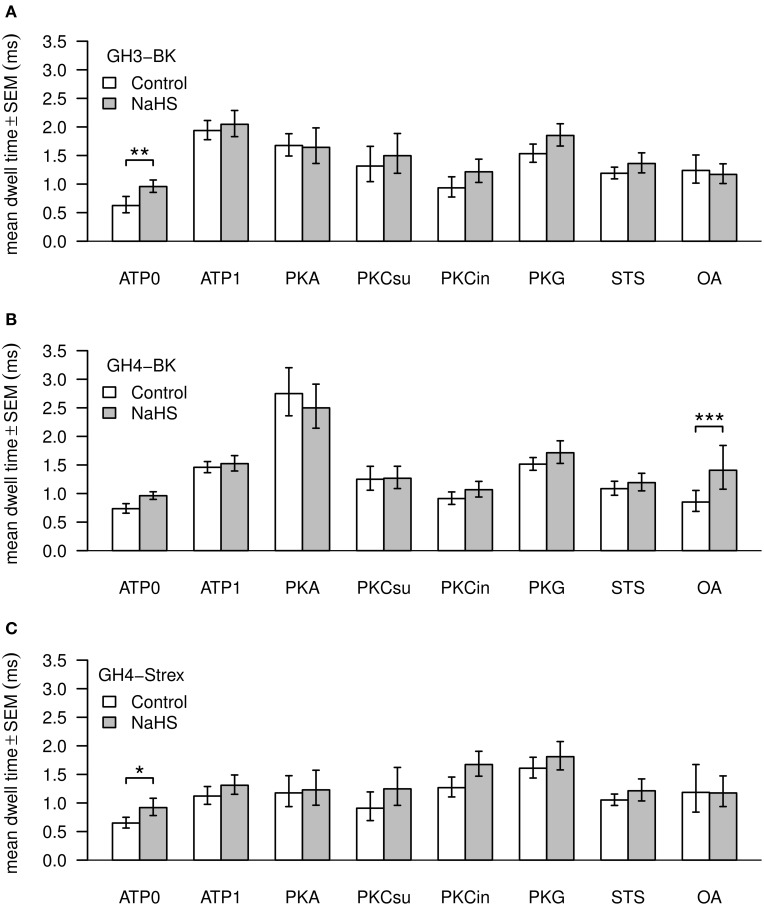
Mean values of BK channel open dwell times. Three types of channels—GH3-BK (A), GH4-BK (B), and GH4-STREX (C) cells were investigated. Bar graphs show open dwell values in ms under control conditions (left bars, white) and after extracellular application of 300 μM NaHS (right bars, gray). All drug concentrations were the same as shown in Figure 3. Significant *0.05 > p > 0.01; high significant **0.01 > p > 0.001; most significant ***p < 0.001.